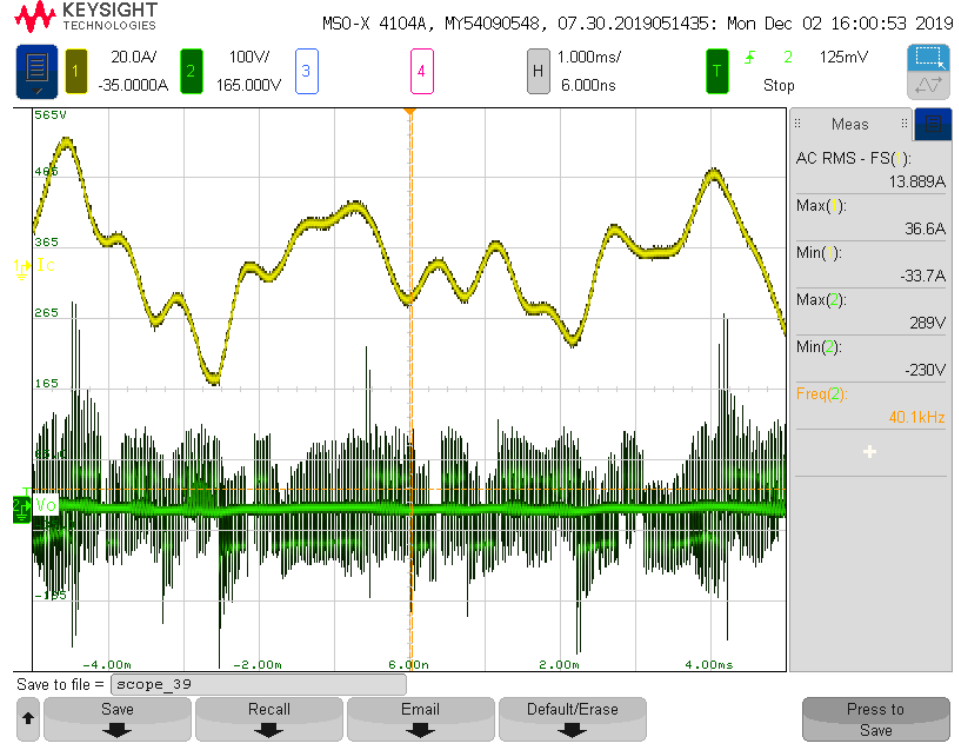
Figure 23. Compensating current I C (yellow) and output voltage v O (green). Zoomed version of Figure